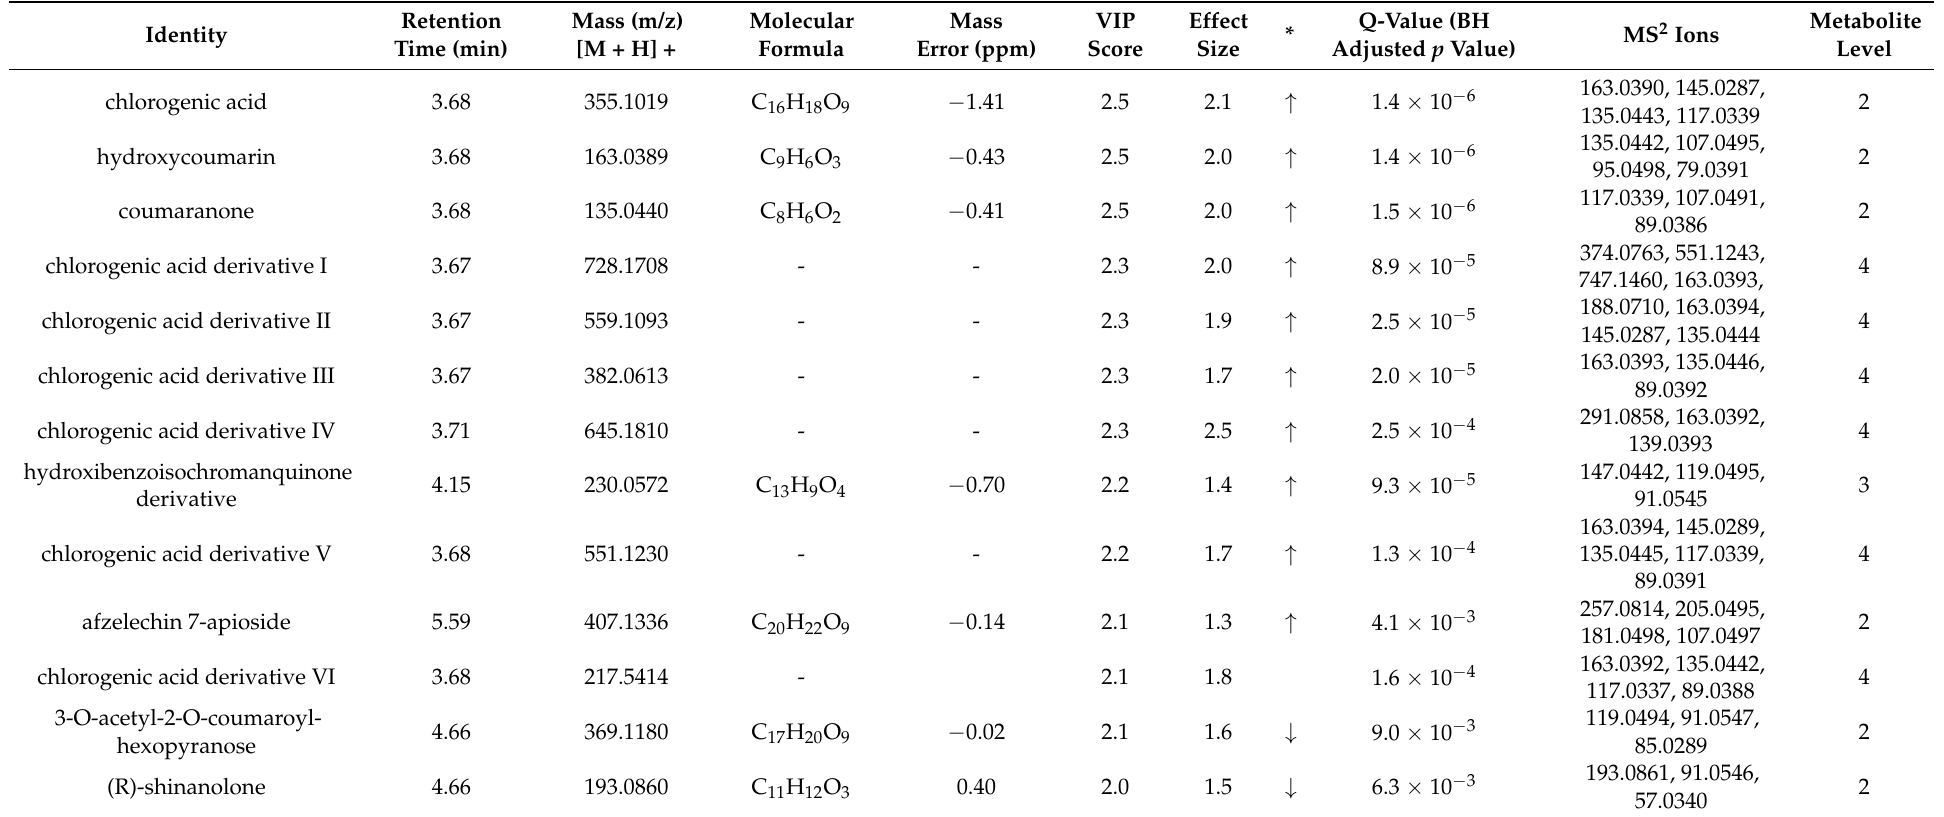
Table 1. Metabolites identified in UHPLC-HRMS ESI+ data that were significant (VIP > 1.5) in the OPLSDA model between NV HIGH compared to NV LOW apple spur buds with associated effect size. Benjamini–Hochberg adjusted p values (Q-values) indicate those metabolites that are significant in the linear model with the (y ~ return bloom) for NV LOW , NV MID and NV HIGH